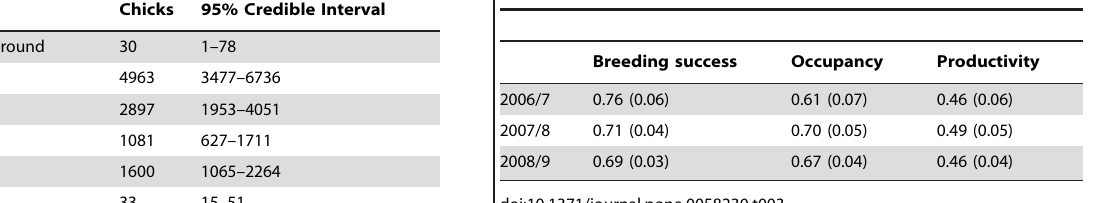
Table 3. Mean (PSD) breeding success (chicks egg 2 1 ), occupancy (eggs burrow 2 1 ) and productivity (fledgings burrow 2 1 ) of burrows in the Clear Place study colony over three